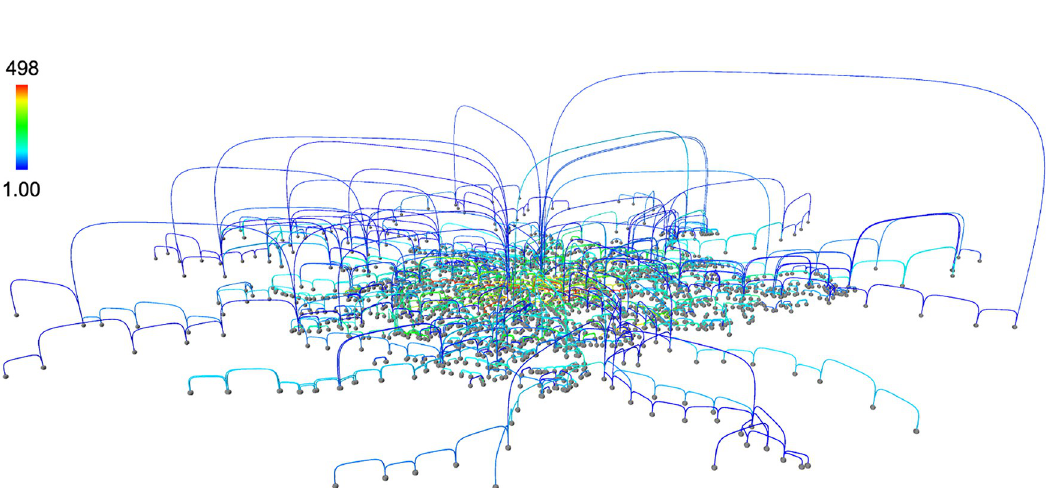
Fig 4. Paris public transports. Nodes are stops and links is travel connections. Mixed modes of travel are included (tram, rail, metro and bus). The color of the links indicates the number of vehicles that used that connection on a Monday. Only the connections covering a physical distance above 500 meters are displayed for the sake of simplicity. Data available from [13]. The network visualization has been generated with Vizaj using a Square shape for the links.